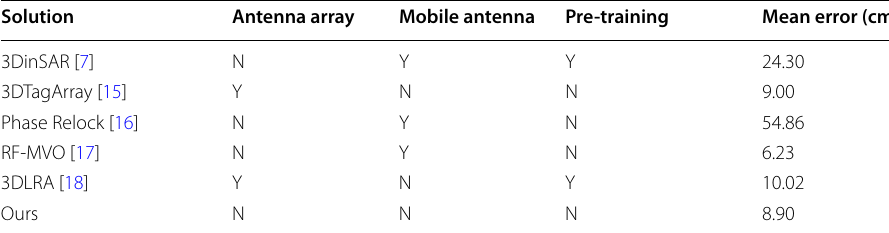
Table 1 Comparisons with existing algorithm